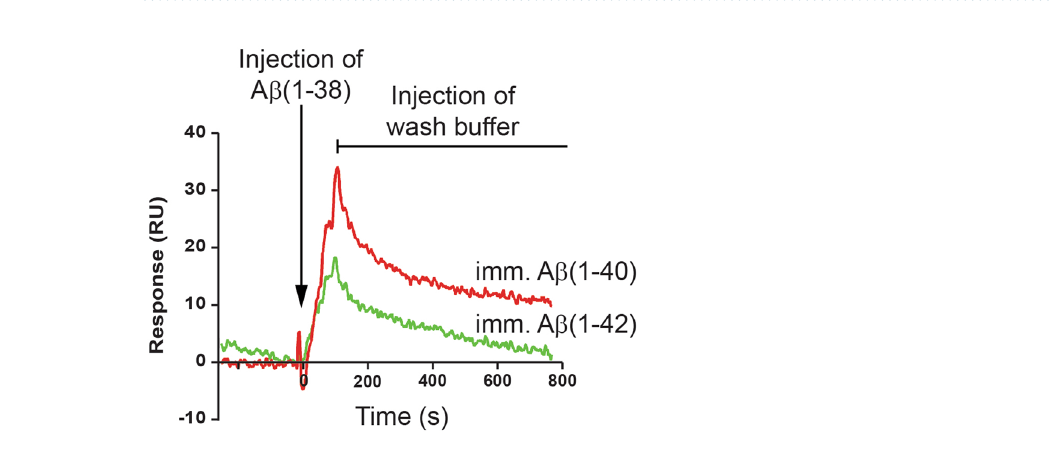
Figure 10. Surface plasmon resonance reveals Aβ(1–38) can interact directly with Aβ(1–42) and Aβ(1–40). A biosensor chip was prepared by immobilizing (imm.) freshly prepared Aβ(1–40) or Aβ(1–42) peptides on to flow cell surfaces. A 1200 nM solution of the analyte, e.g. Aβ(1–38), was injected (5 µL/min) for 120 s over the surfaces, and then replaced with wash buffer, thus yielding association and dissociation phases, respectively. The binding of Aβ(1–38) with Aβ(1–40) is depicted by the red sensorgram, while the binding with Aβ(1–42) is depicted by the green